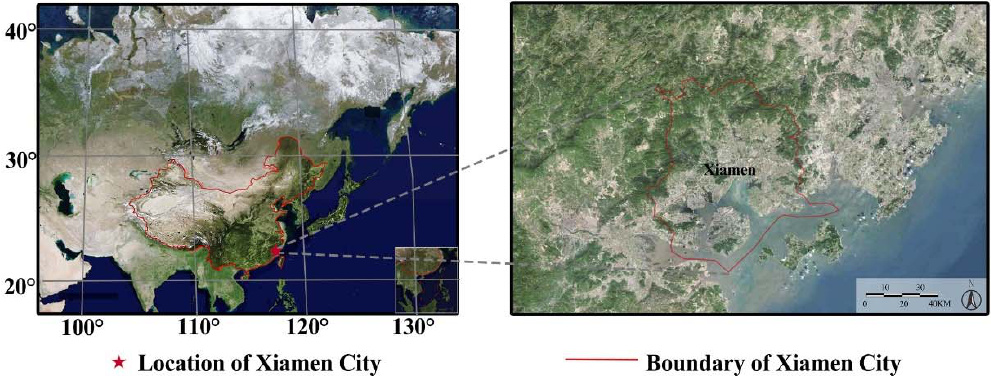
Figure 1. Location of Xiamen city, China (source: Google Maps).